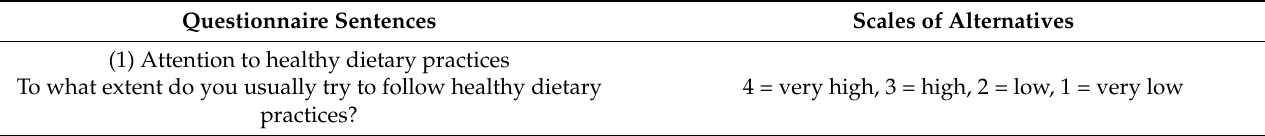
Table 5. Questions and the scales used to measure various dimensions of dietary